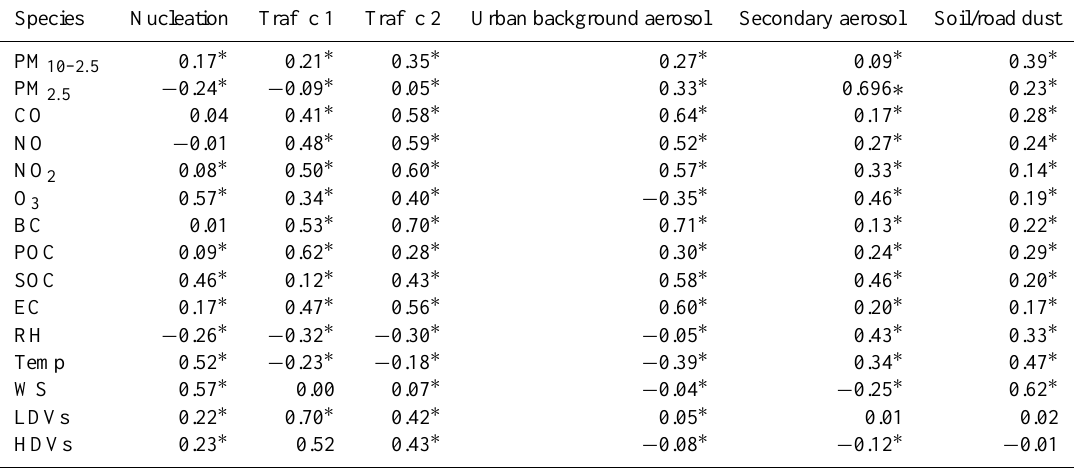
Table 3. Spearman correlation coefficient matrix, indicating the association between the auxiliary variables and the factors resolved by the PMF model. R values above 0.5 are in bold.